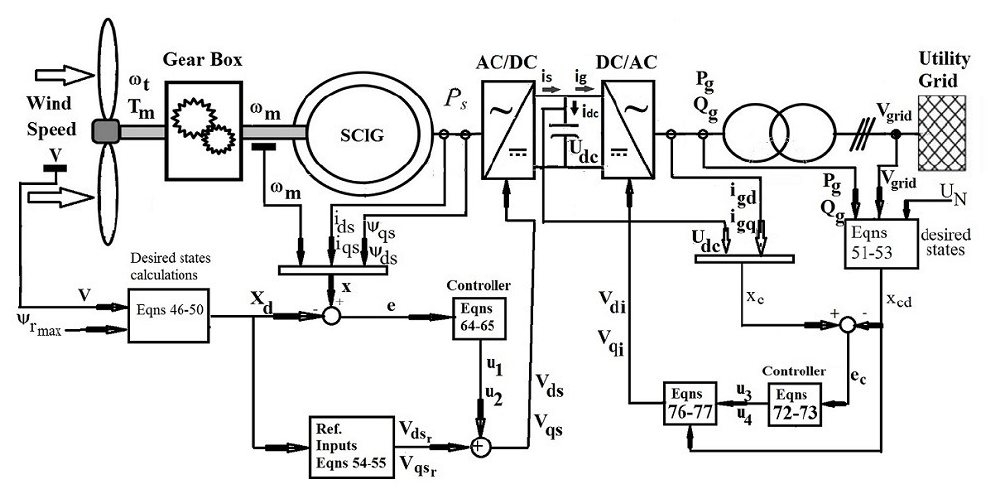
Figure 4. A block diagram representation of the controlled SCIG-based